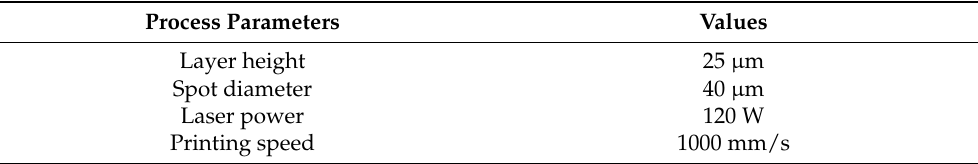
Table 1. Optimized LPBF parameters for 316L SS.